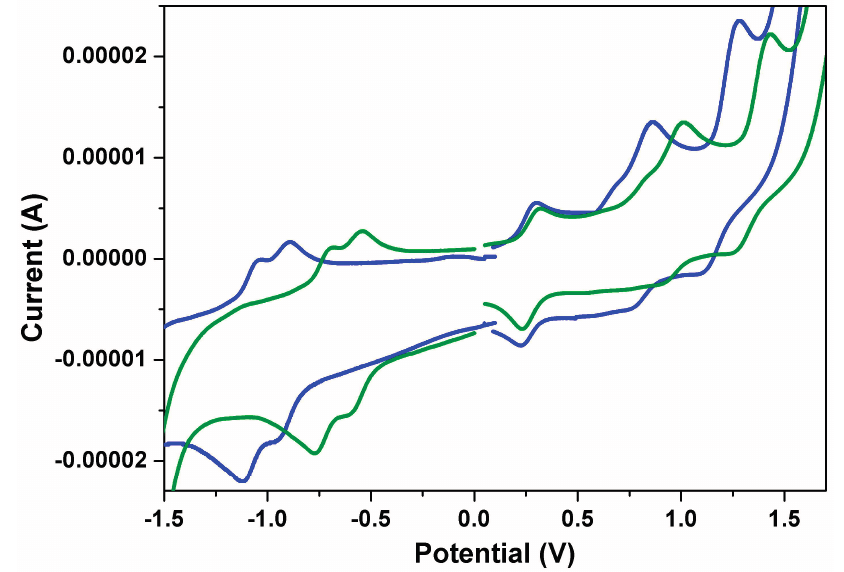
Figure 6. The cyclic voltammograms of 1a (green line) and 2a (blue line) measured in dichloromethane solution with ferrocenium/ferrocene as an internal standard, at 200